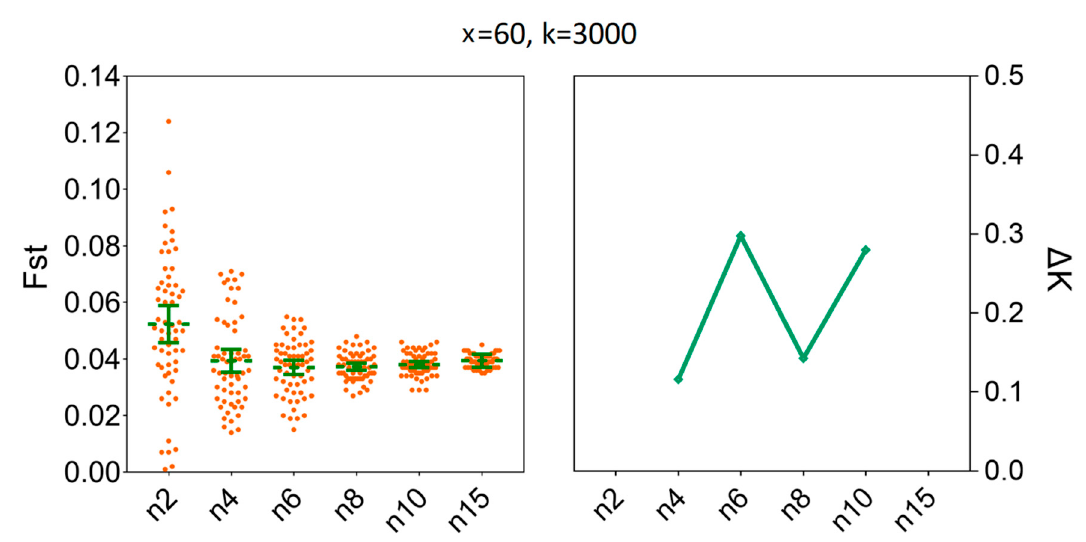
Figure 8. The minimum sample size ( n ) required to estimate Fst between LNSY and PLKK populations. Bars represent sample means and 95% confidence intervals of the means. The ∆ K ( Y -axis) shows a clear peak at the minimum sample sizes ( n ). Fst , pairwise genetic differentiation.